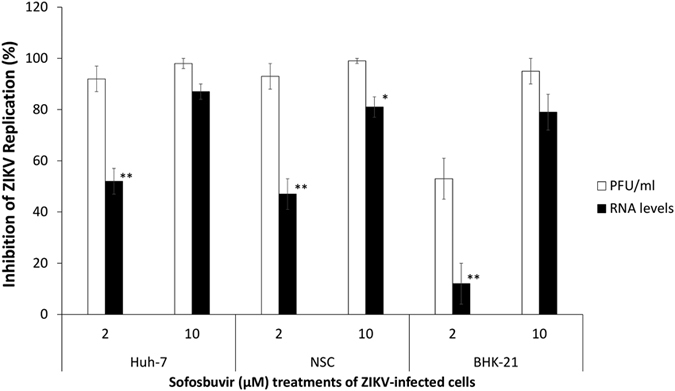
Inhibition of ZIKV-related infectivity and RNA production by sofosbuvir.ZIKV-infected Huh-7 cells, NSCs and BHK-21 cells were treated with or without sofosbuvir. The culture supernatants were collected 24 h after infection to determine the virus infectivity by plaque-forming assays and the viral RNA loads by real time RT-PCR analysis. The data are presented as the percentage over the control (untreated cells). *Indicates a significant difference (P < 0.05) between the black and white bars. **Indicates a significant difference (P < 0.01) between the black and white bars.